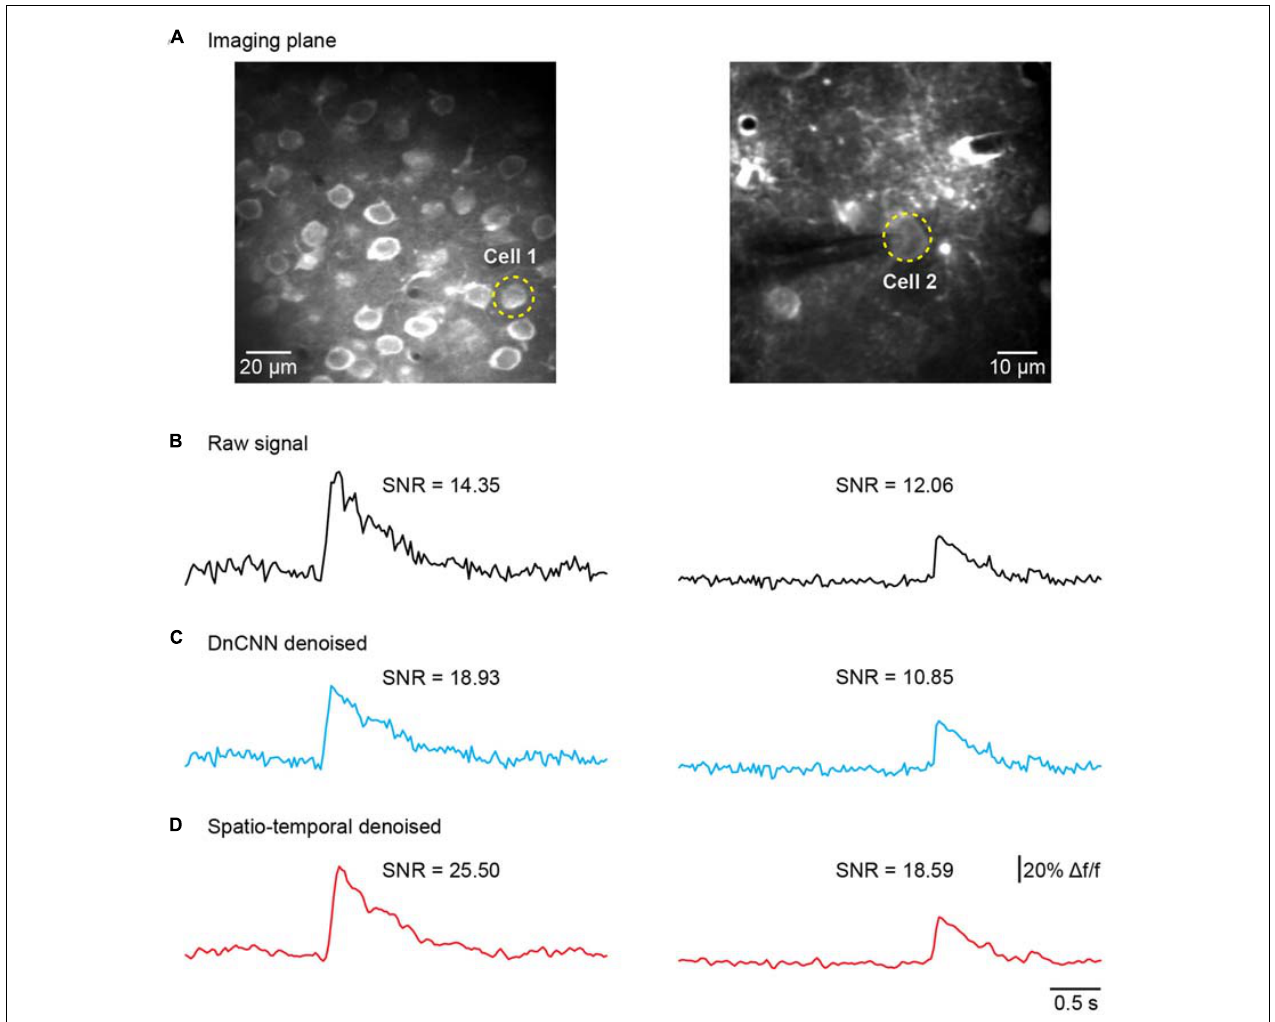
FIGURE 8 | Comparison of temporal denoising performances. (A) Two representative imaging planes generated by averaging; the yellow dashed circles indicate the ROIs in the cells. (B) The raw Ca 2 + signals extracted from the cells in (A) . (C) The extracted Ca 2 + signals with imaging data processed by the DnCNN. (D) The extracted Ca 2 + signals with imaging data processed by model blind spatiotemporal filtering.